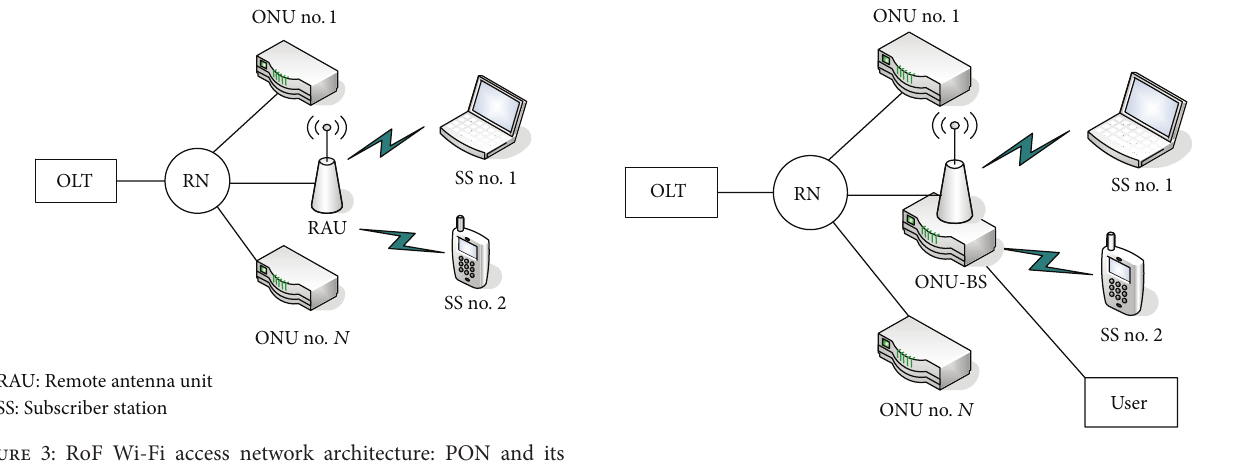
Figure 3: RoF Wi-Fi access network architecture: PON and its wireless extension RAU.